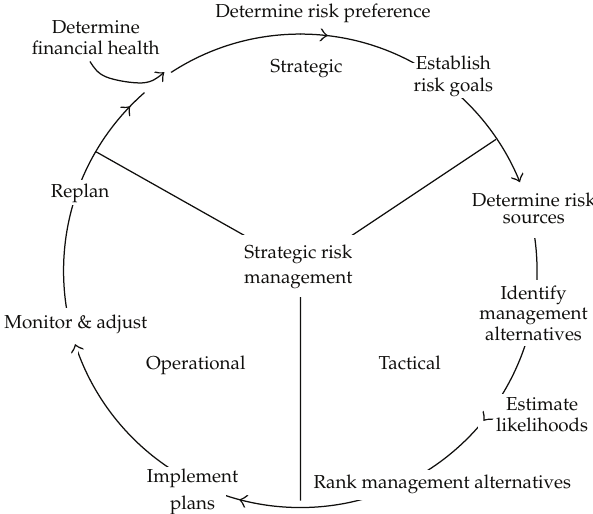
Figure 1: Strategic risk management process; see source in the study of Hoag in (cid:4) 6 (cid:5)